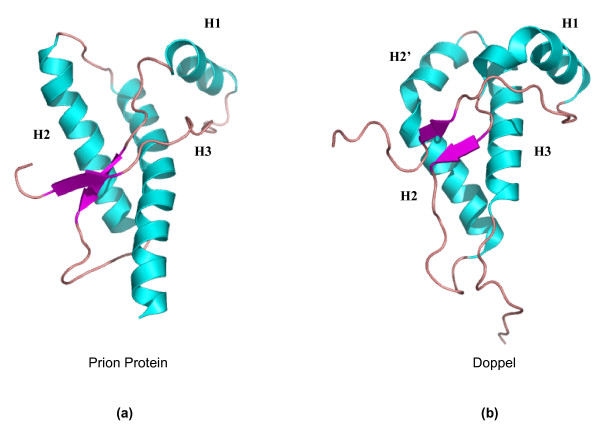
Starting 3D structures of Prion and Doppel. PDB derived starting structures of the Prion Protein (a) and of the Doppel Protein (b). The two structures are coloured according to secondary structures. Different secondary structure elements are also labelled in bold characters.